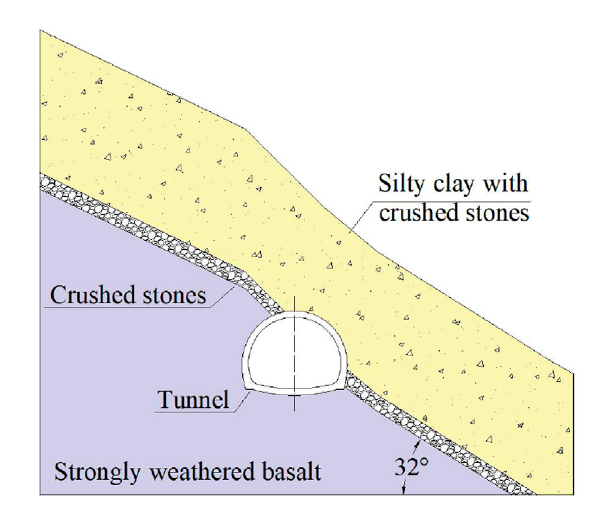
FIGURE 2 Geological cross-section pro fi le of the tunnel entrance